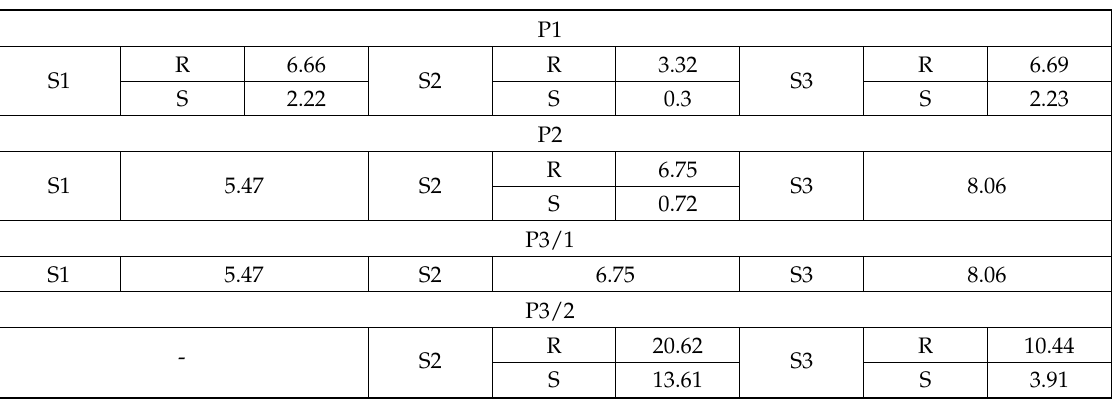
Table 4. Values of the theoretical material removal rate ( Q w ).